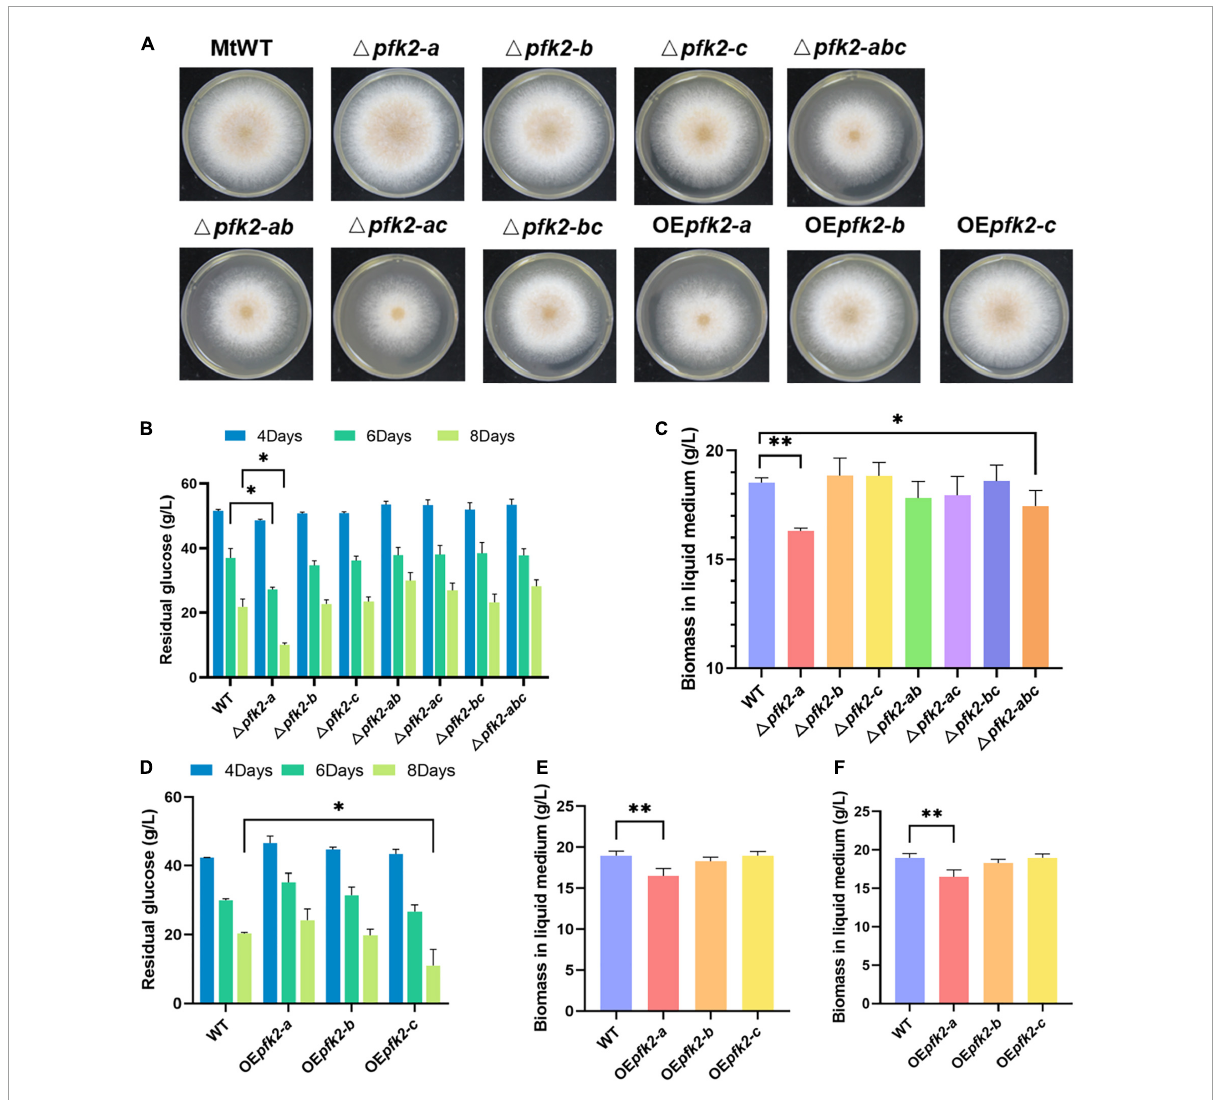
FIGURE2 Phenotypic analysis of the pfk2 knockout mutants and overexpression strains. (A) Growth comparison of Myceliophthora thermophila WT, knockout mutant and overexpression strains after 3 days of culture on solid plates. Comparison of glucose consumption (B) and biomass in liquid medium (C) between WT and the mutant strains after 8 days of culture in liquid media. Comparison of glucose consumption (D) , biomass in liquid medium (E) , and glucose consumption/unit biomass (F) between the WT and overexpression strains after 8 days of culture in liquid media. Values and error bars represent means and standard deviations of independent triplicate experiments, respectively. ∗ p < 0.05; ∗∗ p <